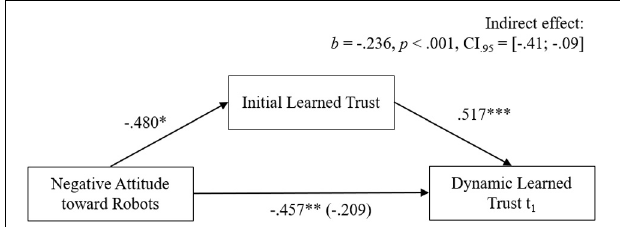
FIGURE 5 | Findings for the mediation from negative attitudes toward robots to dynamic learned trust by initial learned trust.